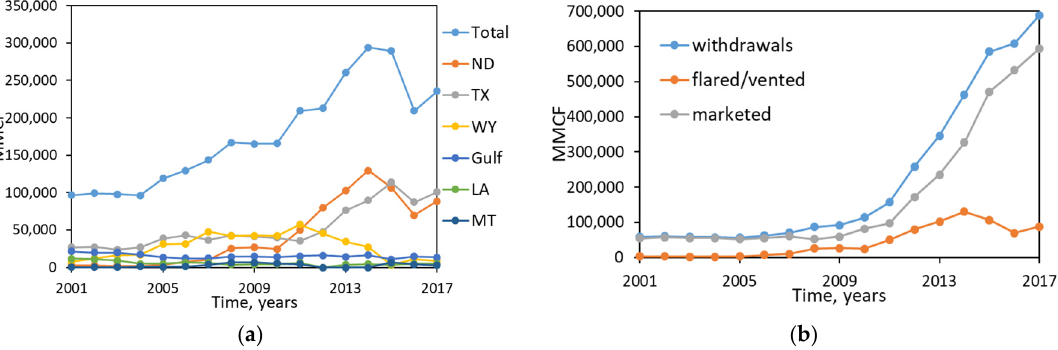
Figure 8. ( a ) Total flared / vented natural gas in United States; ( b ) P \ produced, marketed, and flared / vented natural gas in the state of North Dakota. Reproduced from [115], 2019, Energy Information Administration (EIA).